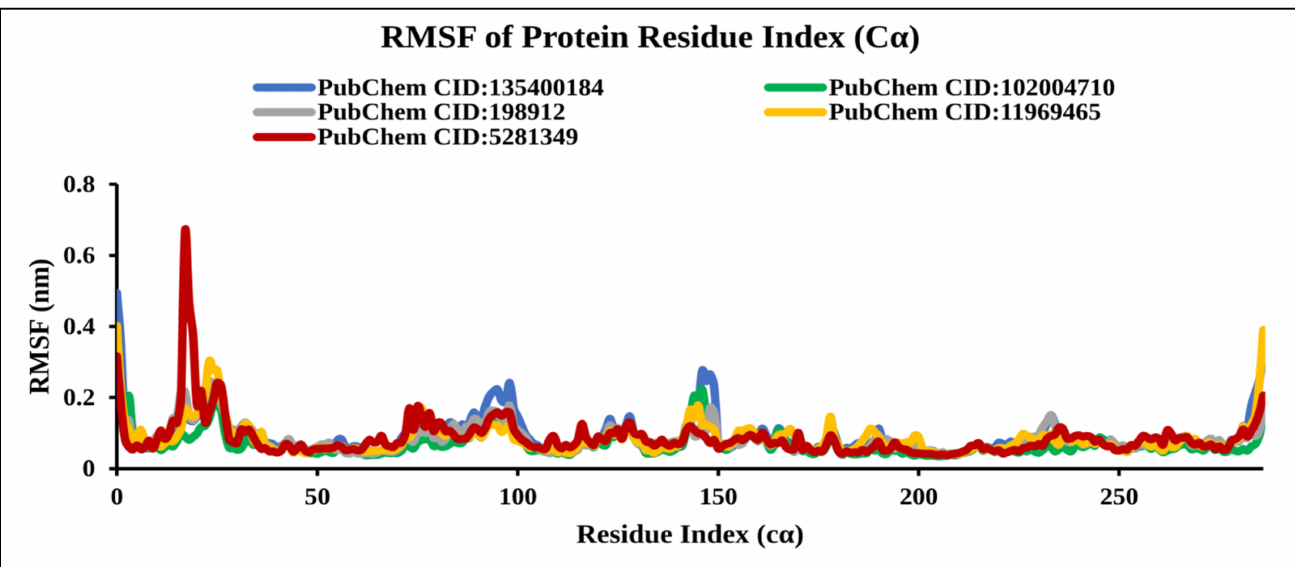
Figure 11. Line graph showing RMSF values of the complex structure extracted from protein residues C α atoms, viz: PubChem CID: 135400184 (blue); PubChem CID: 198912 (gray); PubChem CID: 5281349 (dark red); PubChem CID: 102004710 (green); and PubChem CID: 11969465 (yellow) to 50 ns simulation